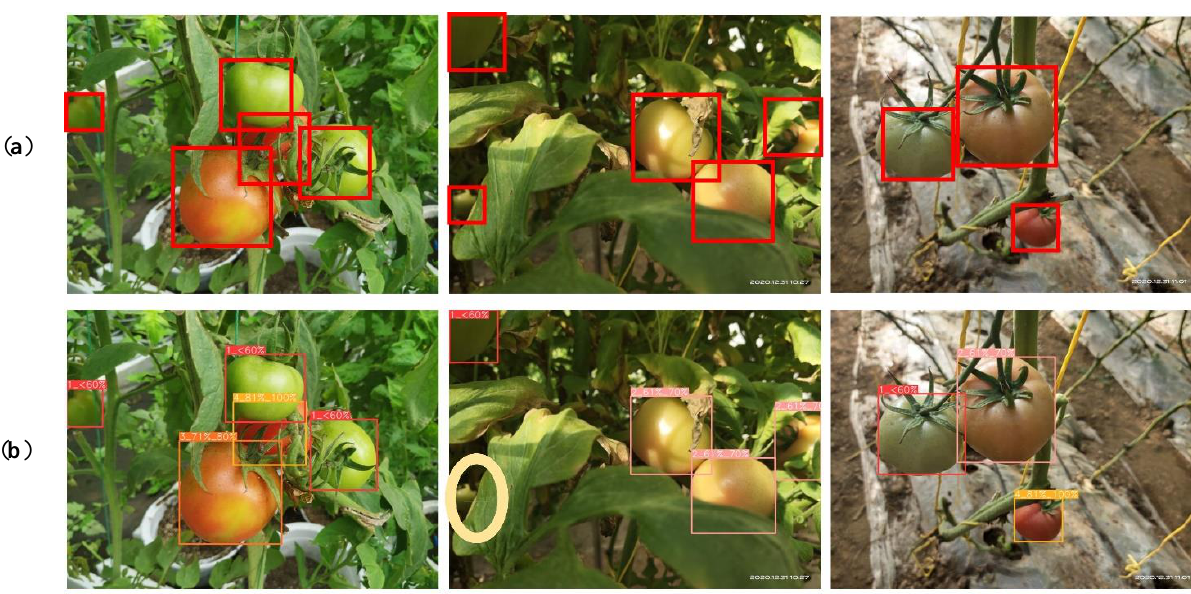
Figure 11. The predicted performance of four models. ( a ) Manually marked initial image; ( b ) YOLOv3 model; ( c ) YOLOv3-MobileNetV1 model; ( d ) SE-YOLOv3-MobileNetV1; ( e ) YOLOv5. 4. Discussion The proposed SE-YOLOv3-MobileNetV1 model in this paper is compared with the existing tomato maturity classification methods, including laboratory environment, greenhouse environment, and the comparison of different maturity classifications. The results are shown in Table 4. Compared with traditional machine learning methods, the